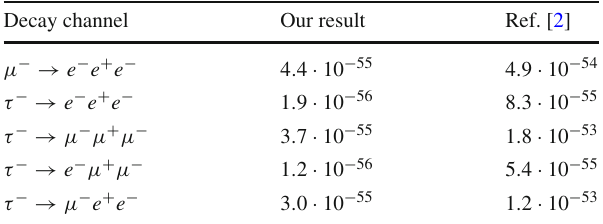
Table 3 Complete results taking into account interference (constants in the Thompson limit are used) Decay channel Our